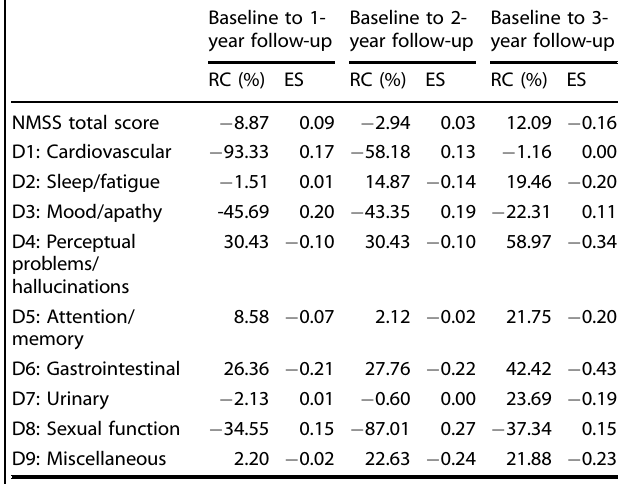
Table 1. Relative changes and effect sizes from baseline to 1-, 2-, and 3-year